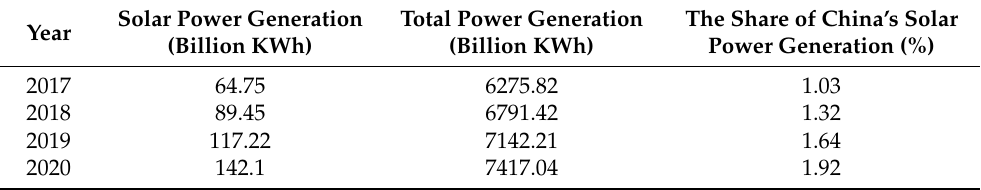
Table 2. Share of China’s solar power from 2017 to 2020.